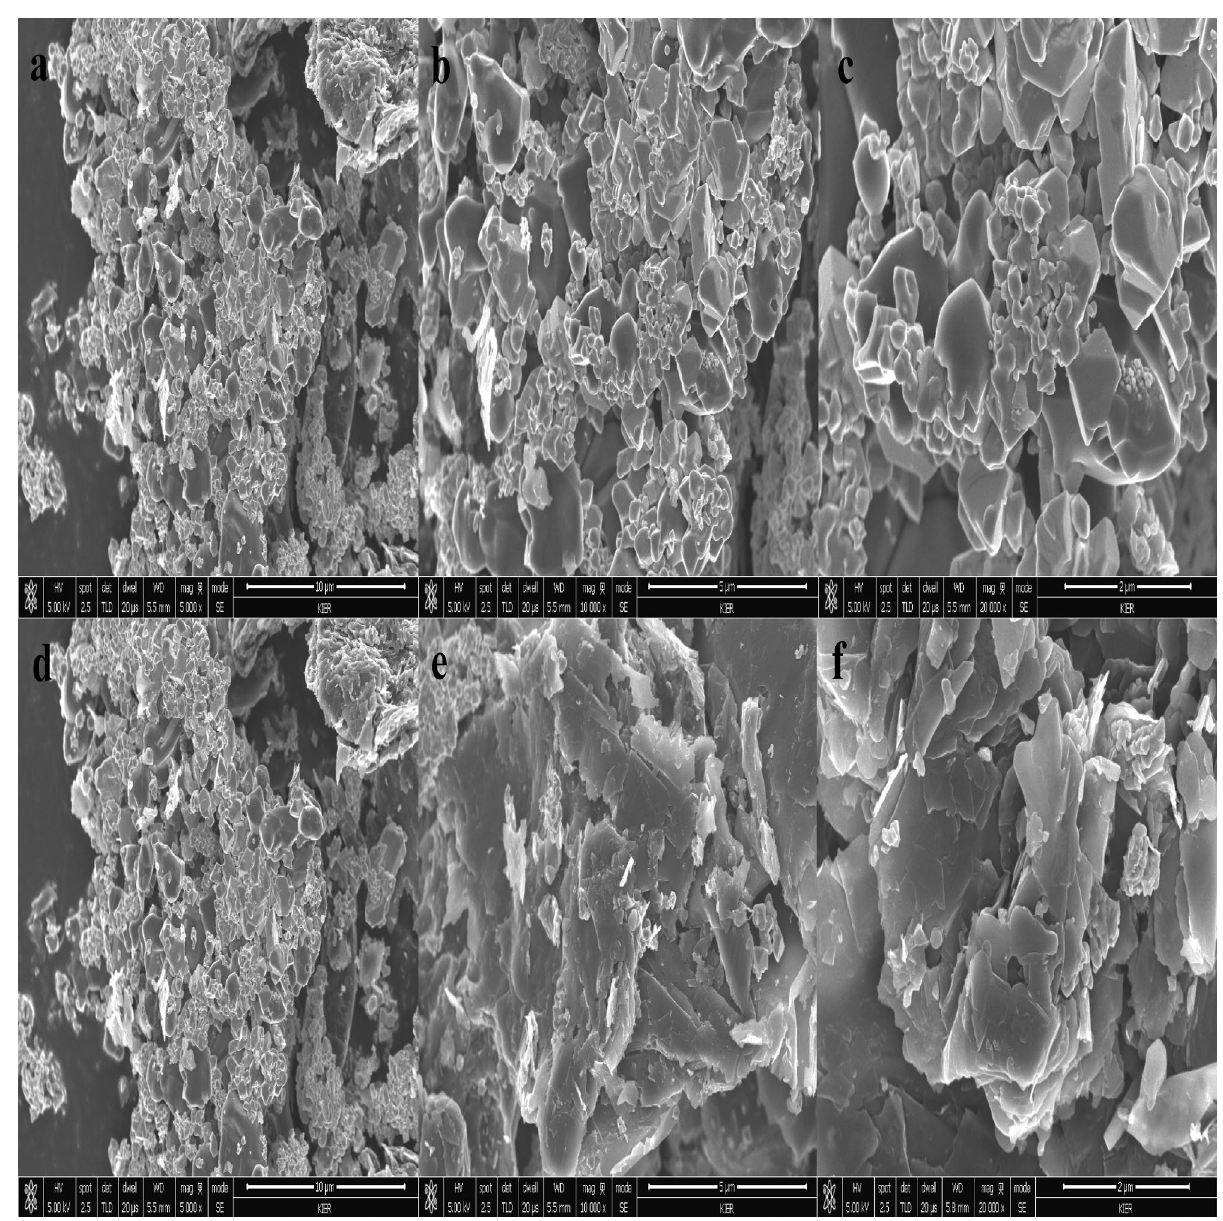
Figure 5. FE-SEM images of bi-metallic ( a – c ) Ti x Ta (4−x) AlC 3 MAX phase and ( d – f ) Ti x Ta (4−x) C 3 MXene at various